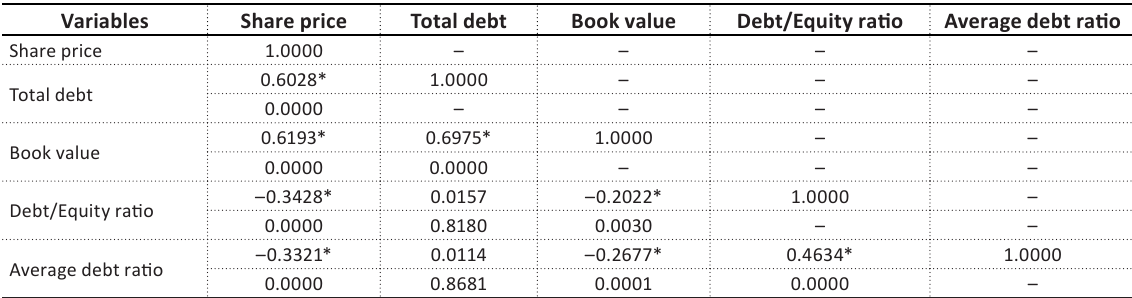
Table 2. Correlation